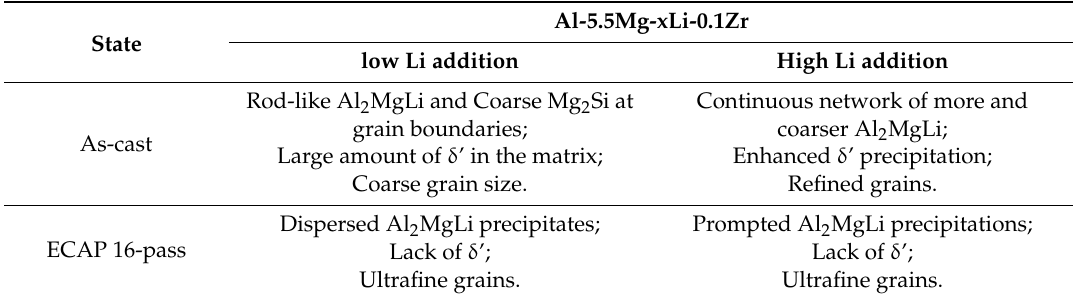
Table 2. Summary of the main features of the microstructure in the Al-5.5Mg-xLi-0.1Zr alloy at di ff erent